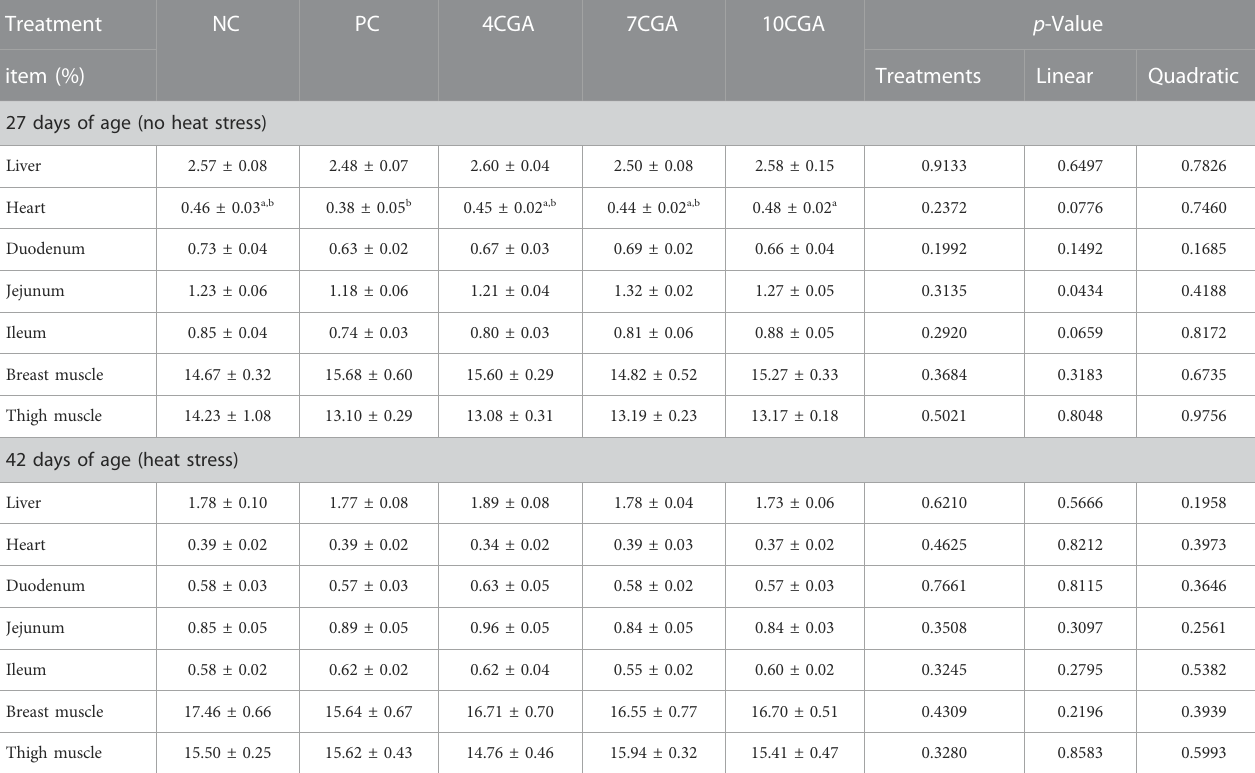
TABLE 3 Effects of in ovo feeding of chlorogenic acid on organ proportion of broilers. Treatment